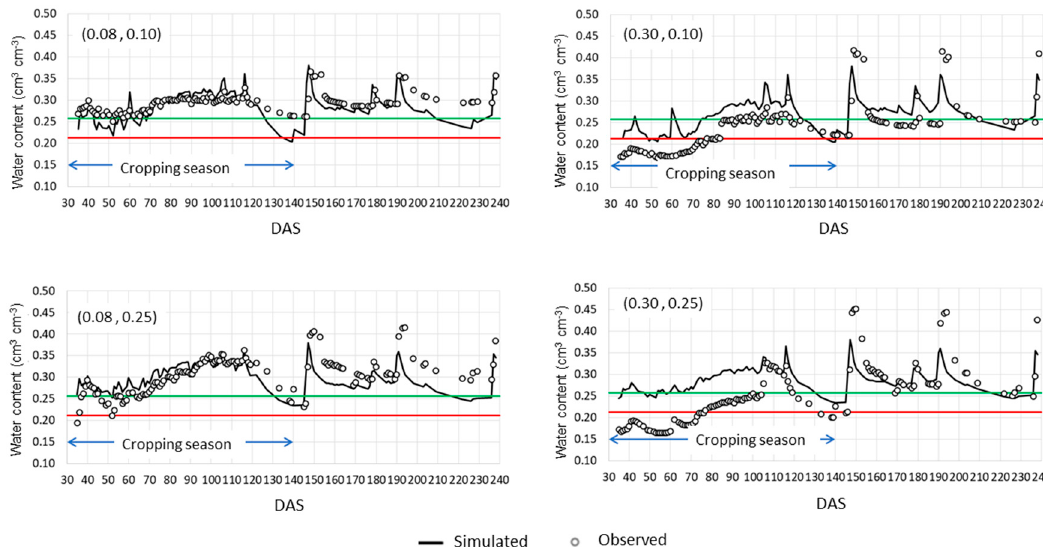
Figure 4. Comparison of simulated and observed soil water contents in the 4 positions relative to the dripline position. Time scale in the horizontal axis indicates days after sowing (DAS, 28 May 2019 would correspond to day 0). Volumetric soil water contents at − 20 kPa horizontal red line and − 10 kPa (field capacity) horizontal green line are depicted. Table 3. Model performance statistics for predicted soil water contents at di ff erent positions throughout the soil